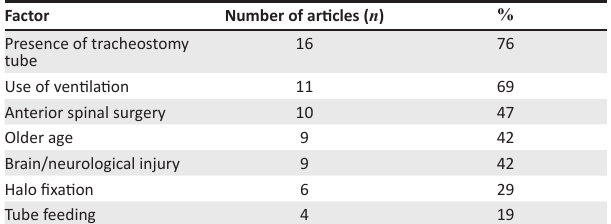
TABLE 3 : Risk factors associated with the development of dysphagia in spinal cord injury. Factor Number of articles ( n